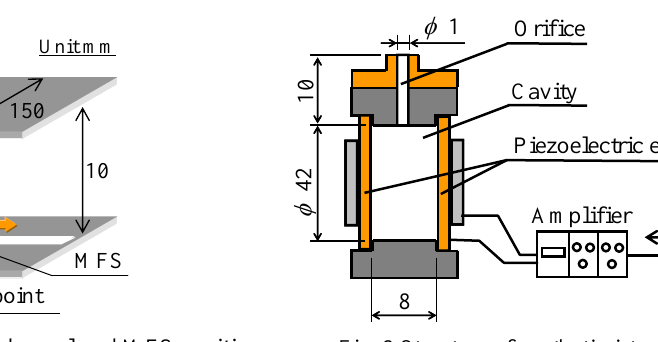
Fig. 2 Structure of synthetic jet actuator.